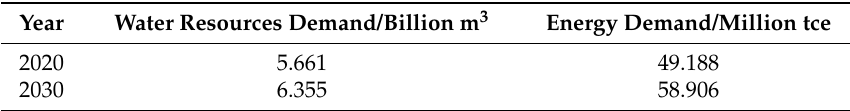
Figure 6. MLR fitting results for energy demand. Table 4. MLR Forecast results of water-energy demand for